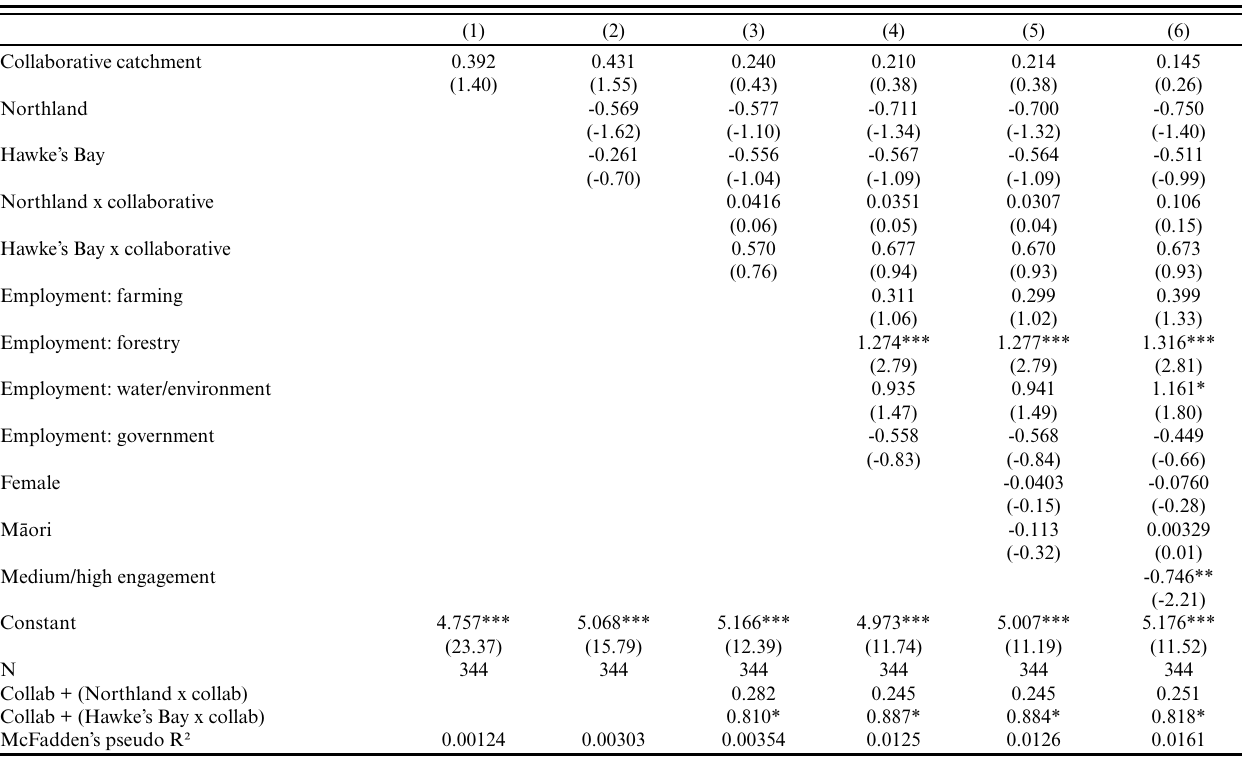
Table 4 . Perceptions of the fairness of processes for water management (“Using a scale from 0 to 10, where 0 means not fair at all and 10 means very fair, in your opinion, how fair do you think the water management processes are in the [name of regional council]